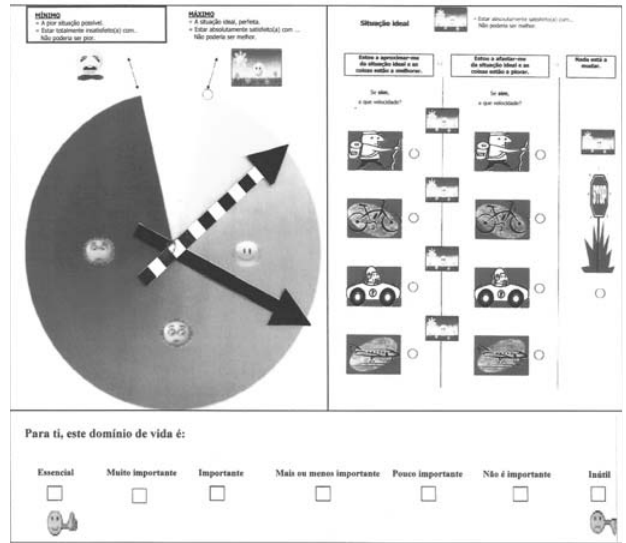
Figura 2 . Formato do